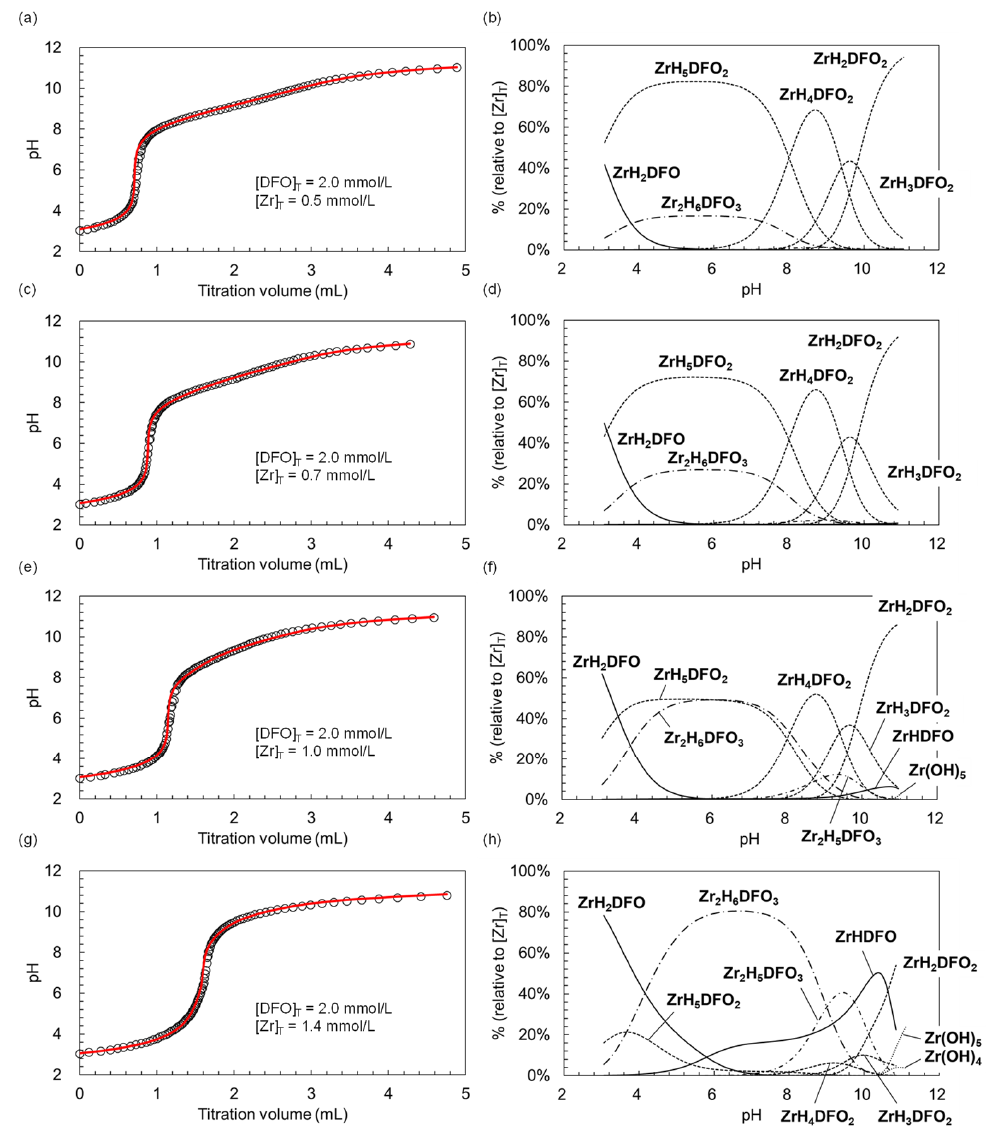
Figure 3. Titration curves and speciation curves of Zr-DFO complex in the co-presence of DFO ([DFO] T = 2.0 mmol/L) and ( a , b ) [Zr] T = 0.5 mmol/L (DFO/Zr ratio = 4.0); ( c , d ) [Zr] T = 0.7 mmol/L (DFO/Zr = 2.85); ( e , f ) [Zr] T = 1.0 mmol/L (DFO/Zr = 2.0); and ( g , h ) [Zr] T = 1.4 mmol/L (DFO/Zr = 1.43). Each circle in the titration curve shows an experimental value. The solid red line shows the theoretical curve calculated from the stability constants determined in the potentiometric titration. Speciation curves were generated from Equation (2). All titrations were performed at 25 °C in ion strength of 0.15 mol/L NaCl. Table 2. The log β pqr of Zr-DFO complexes determined in this study.